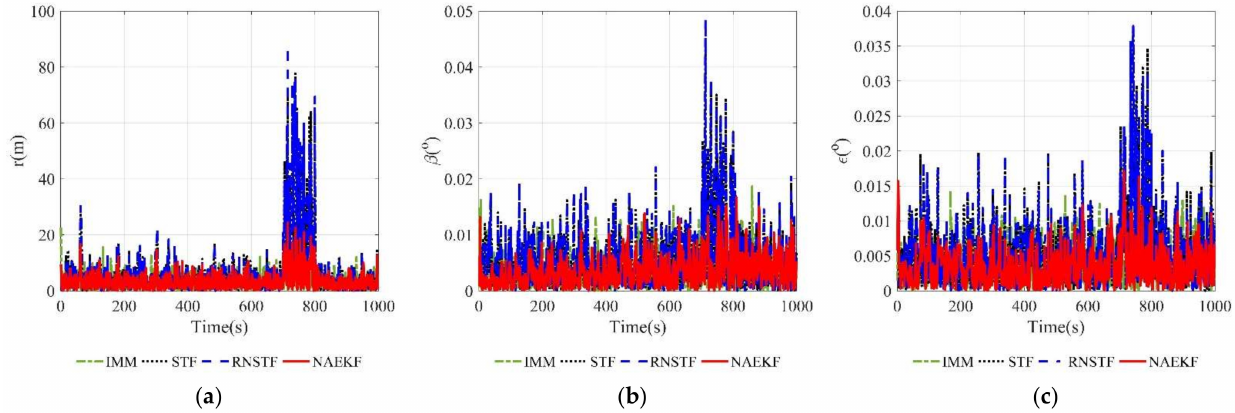
Figure 19. Position estimation errors. ( a ) Estimation errors of the range; ( b ) Estimation errors of the azimuth angle; ( c ) Estimation errors of the elevation angle.